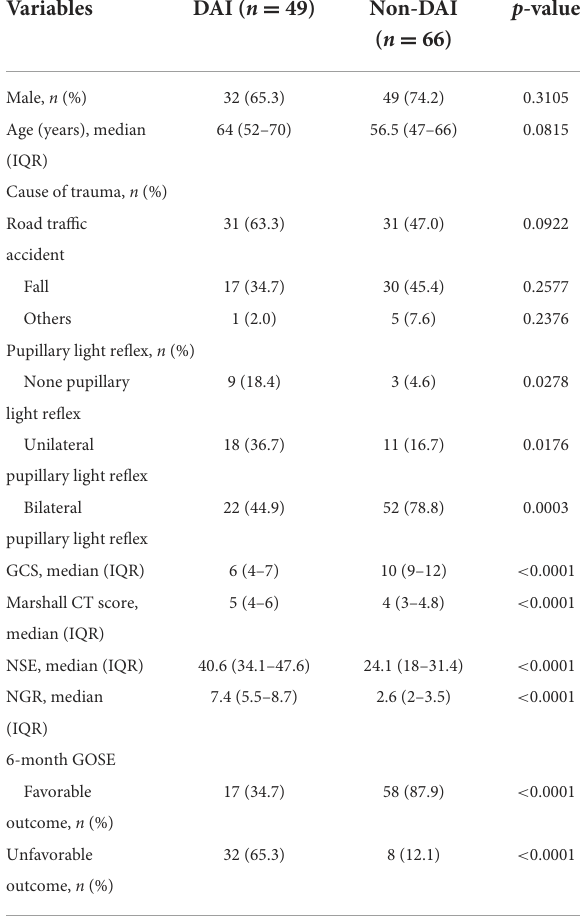
TABLE 1 Demographic and clinical characteristics of eligible patients with diffuse axonal injury (DAI) and non-DAI.